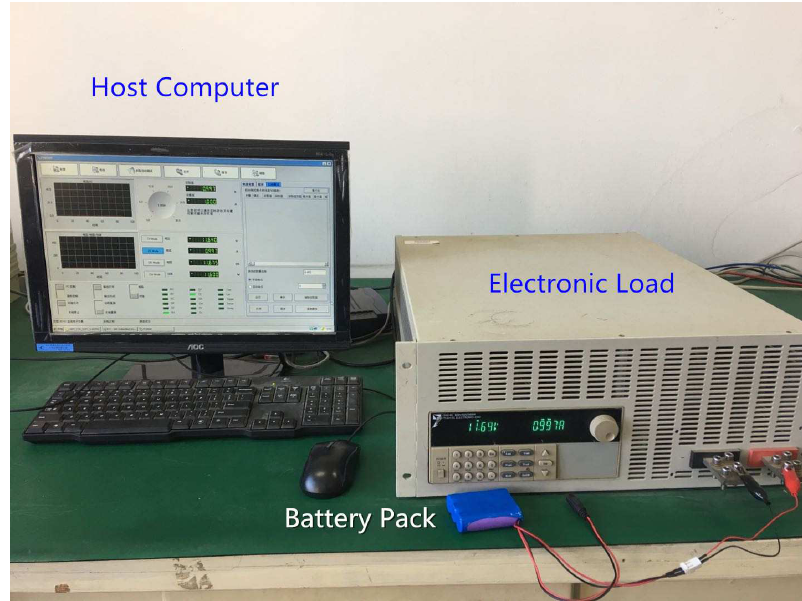
Figure 2. The experimental